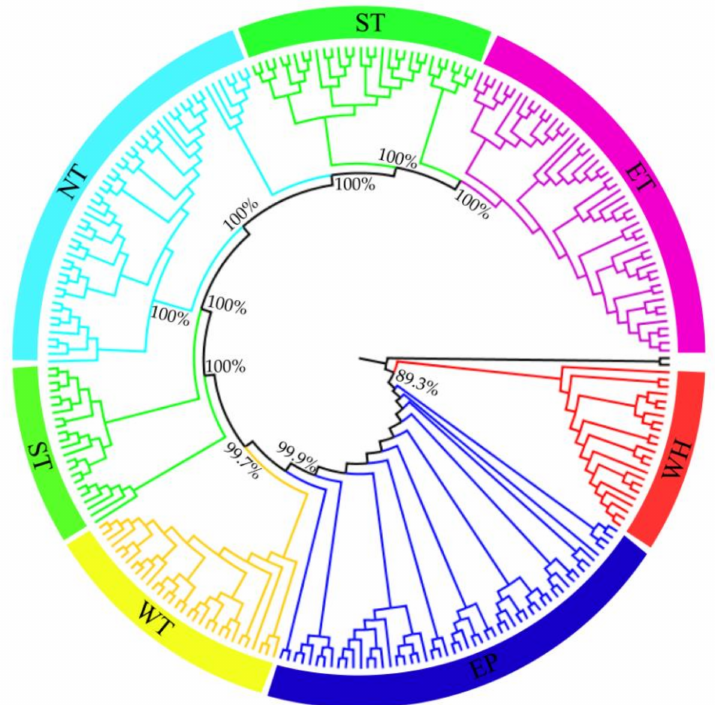
Figure 4. Maximum likelihood (ML) phylogenetic tree of 263 individuals from 37 sampled popula- tions and two outgroup species ( C. erythrocarpos and C. bodinieri ) constructed with the genome-wide SNP dataset. The color-coded clades indicate different geographic groups of C. spinosa with red (western Himalayas), blue (eastern Pamirs), yellow (western Tianshan), azure (the northern piedmont of Tianshan), green (the southern piedmont of Tianshan) and purple (eastern